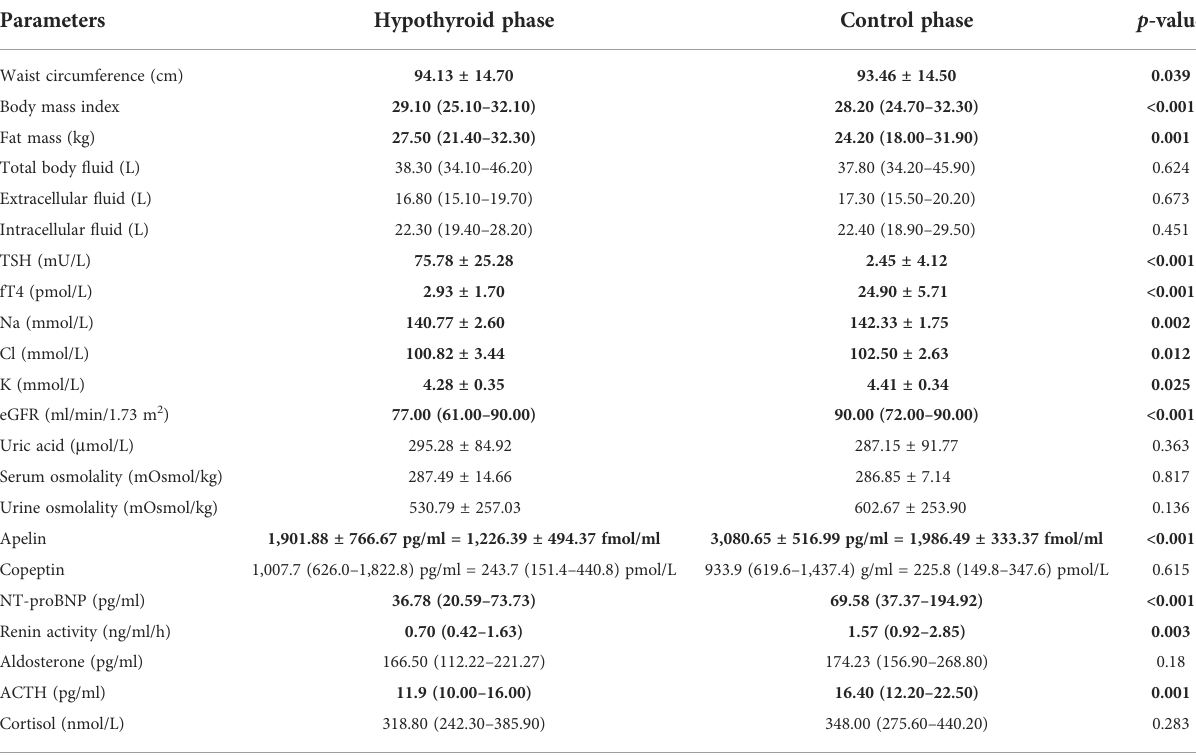
TABLE 1 Comparisons of selected anthropometric and biochemical characteristics between the two study